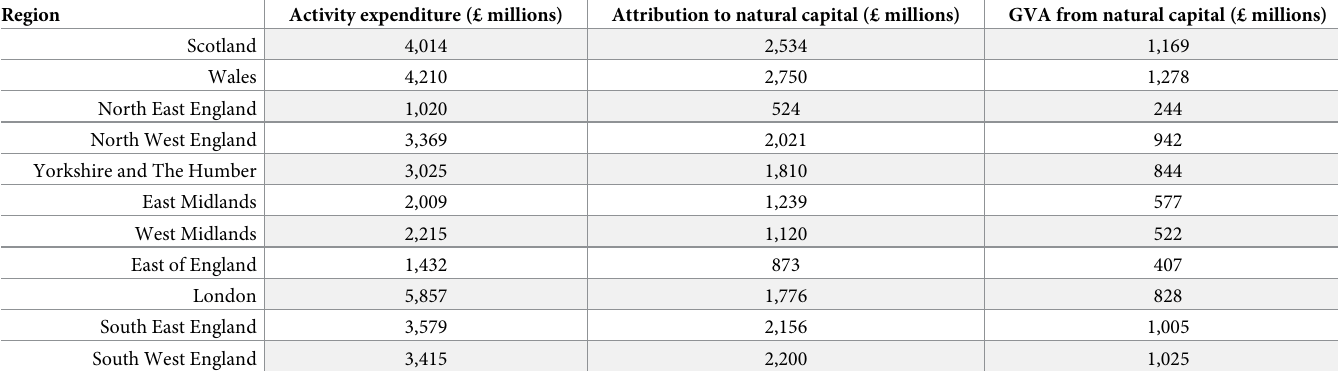
Table 4. T&OL expenditure per region. Total activity expenditure, attribution to natural capital, and natural capital GVA for each region.